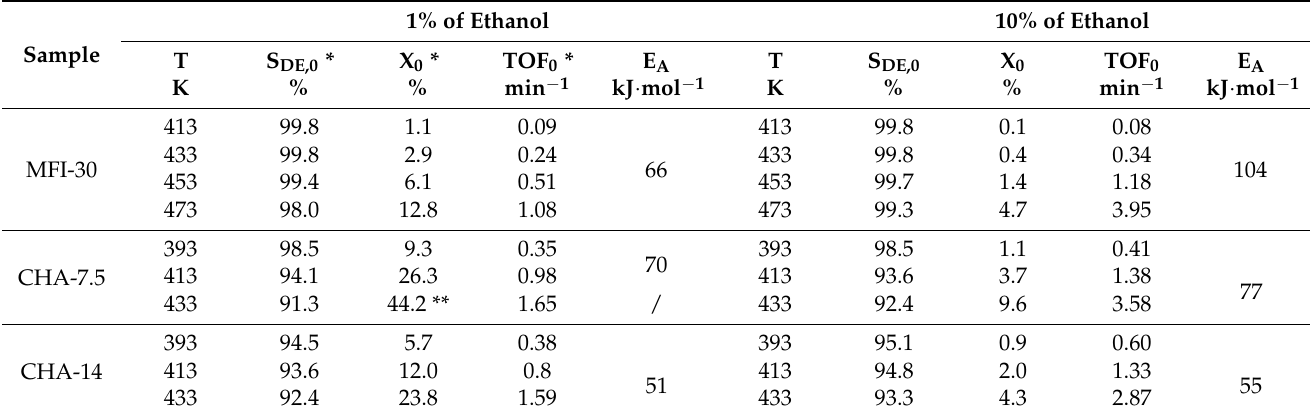
Table 2. Catalytic data over zeolites samples obtained at time on stream (TOS) = 2 min. 1% of Ethanol 10% of Sample